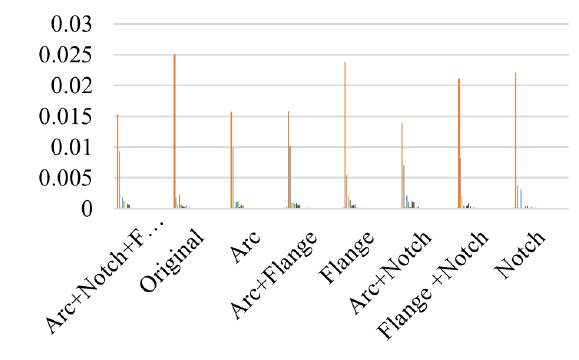
Figure 30. Harmonics of different